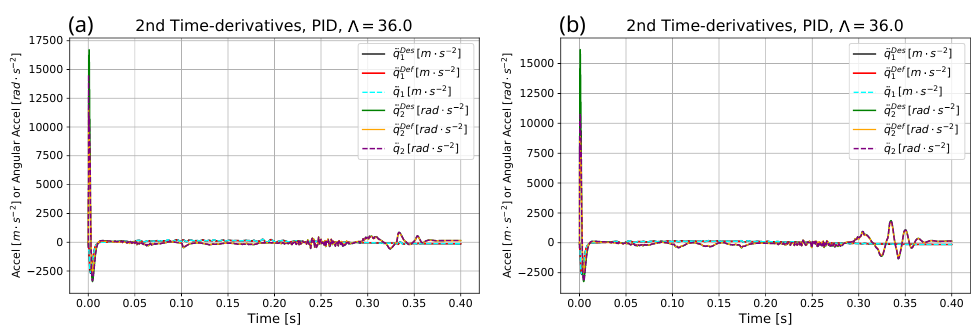
Figure 6. Optimized realized trajectory tracking errors q O − q without force limitation. ( a ) For set 1. ( b ) For set 2.